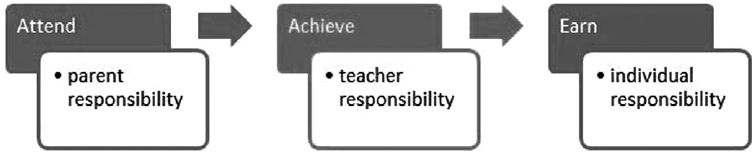
A linear model for the achievement of successful outcomes. who are considered to have the academic ability, skills and aspirations to be successful. (Partington et al., 2009, p.